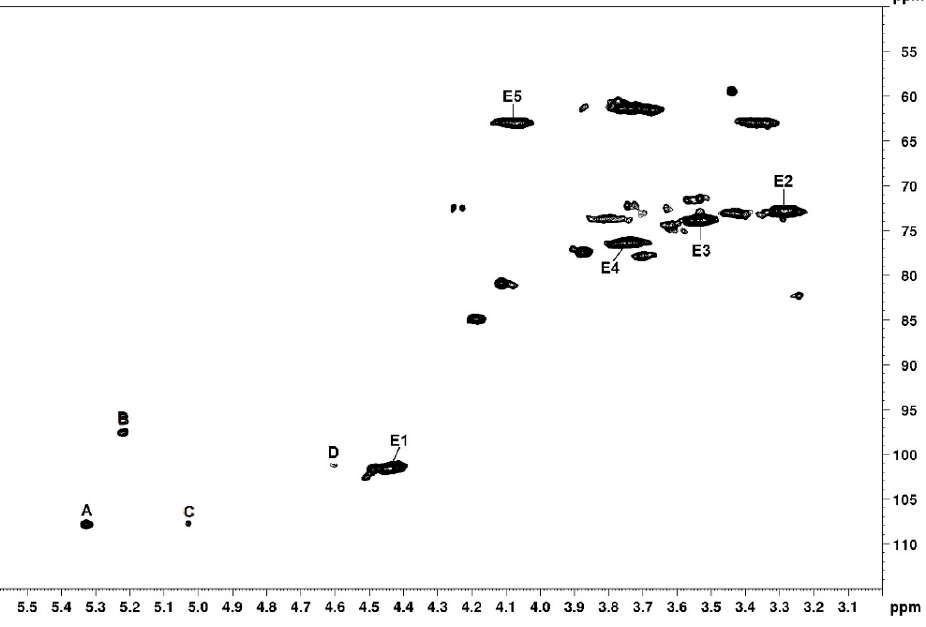
Figure 1. HSQC spectra of xylan from corn cob.